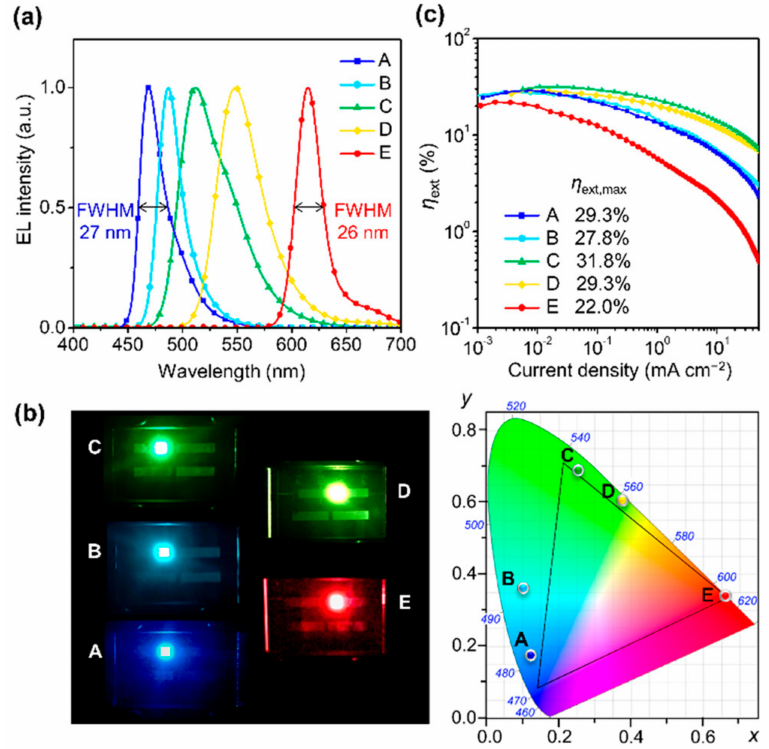
Figure 4. EL characteristics of OLEDs (devices A − E, device B contains compound 110 , device D contains compound 111 ): ( a ) EL spectra measured at 10 mA cm − 2 , ( b ) photographs showing full- color EL emissions (left) and their EL color coordinates in the CIE 1931 chromaticity diagram (right) and ( c ) η ext versus current density plots. (Reproduced with permission from M. Yang et al., Journal of the American Chemical Society; published by ACS Publications, 2020.).